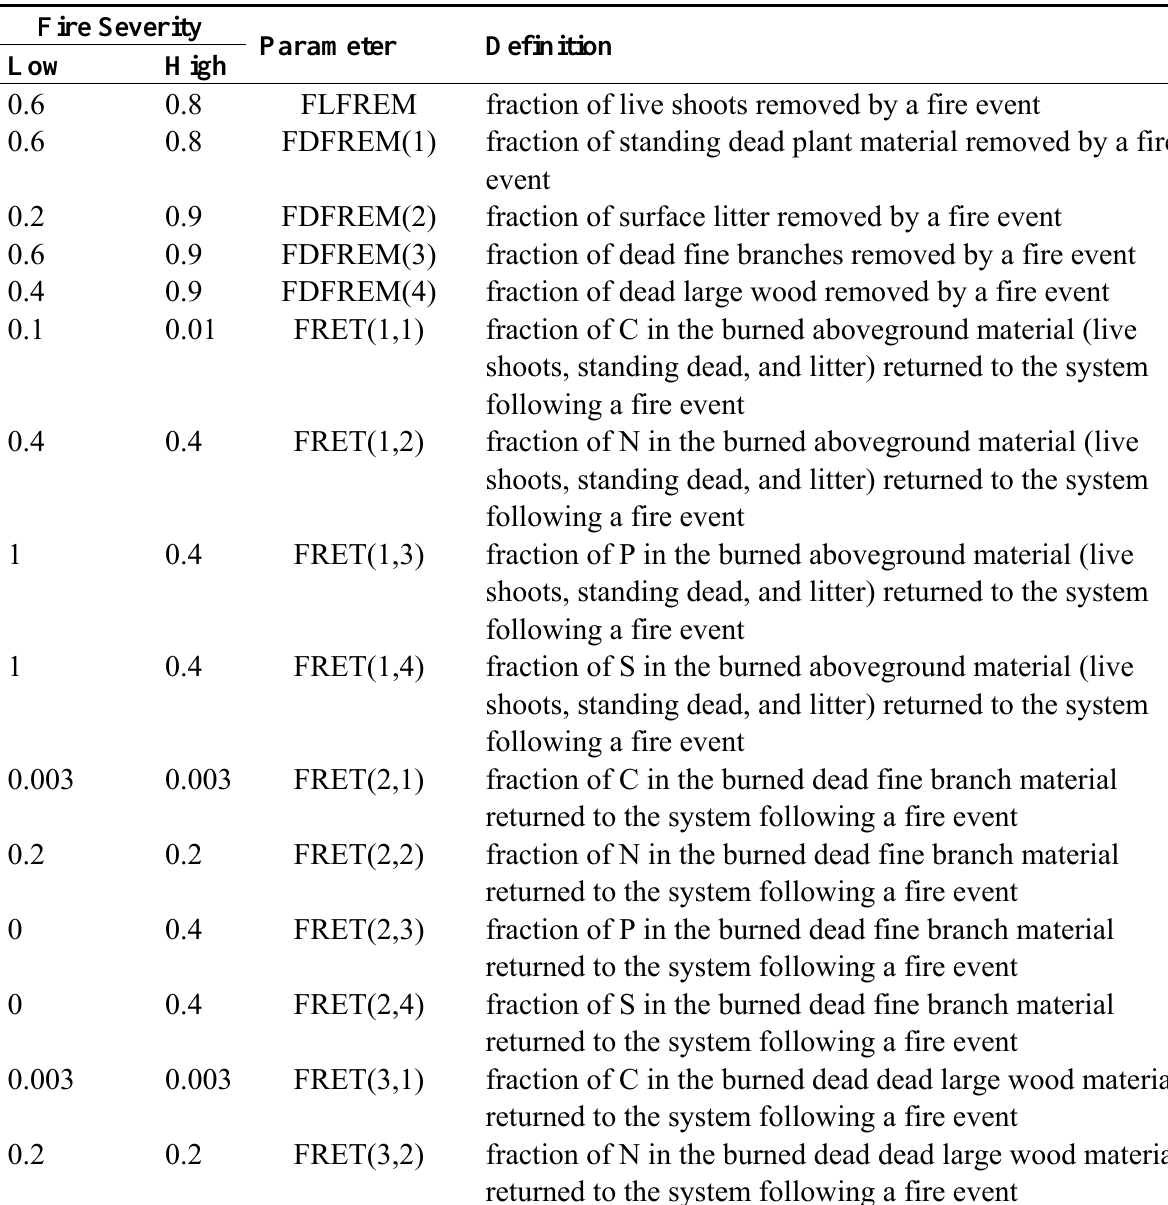
Table 5. A description of DAYCENT input parameters for fire events (FIRE.100) events for either a low fire severity or high severity fire scenario. This subroutine removed mass from litter and grass